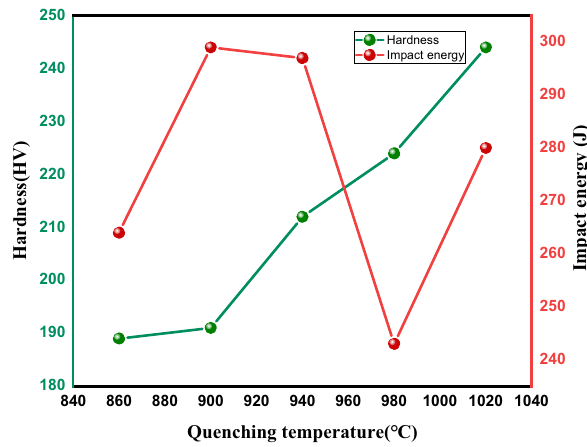
Figure 7: Relationship between mechanical properties of experi - mental steels and quenching